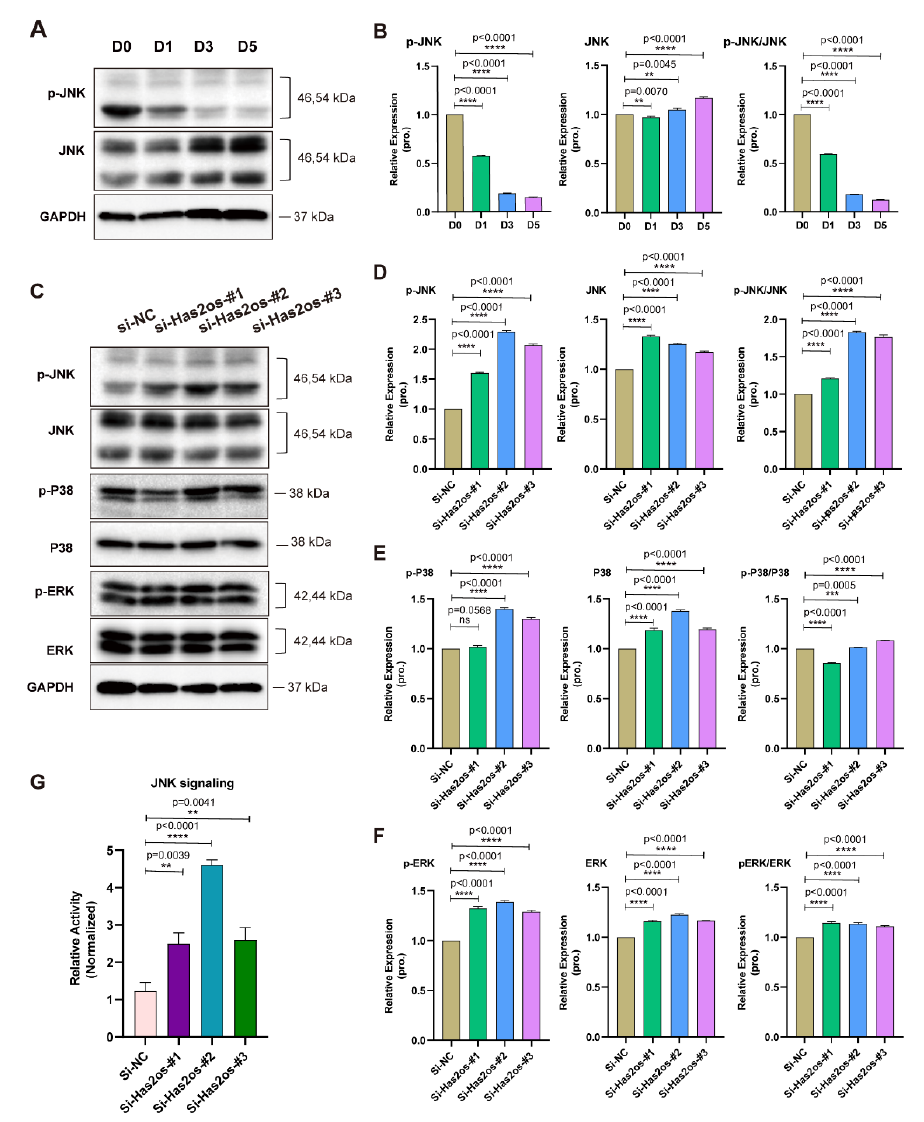
Figure 4. Knockdown of Has2os affected the JNK signaling pathway. ( A ). The JNK signaling pathway is inhibited during skeletal muscle differentiation. The protein expression levels of p-JNK and JNK were detected by Western blot. D0 represents the C2C12 cells in growth medium and D1, D3, and D5 represent cells switched into differentiation medium for 1, 3, or 5 days. ( B ). Relative expression in A were calculated. ( C ). Western blot analysis shows the JNK signaling pathway was activated upon Has2os knockdown, meanwhile, the p38 and ERK signaling pathways slightly changed. ( D – F ). Relative expression in C were calculated. GAPDH was the internal control. ( G ). Relative activity of JNK signaling in C2C12 cells that were transfected with si-Has2os or si-NC. The control plasmid was used as the internal control. The results are normalized to those of with si-NC. Values were presented as means ±SEM. The statistical significance was calculated by t -test; ns, no statistical significance.